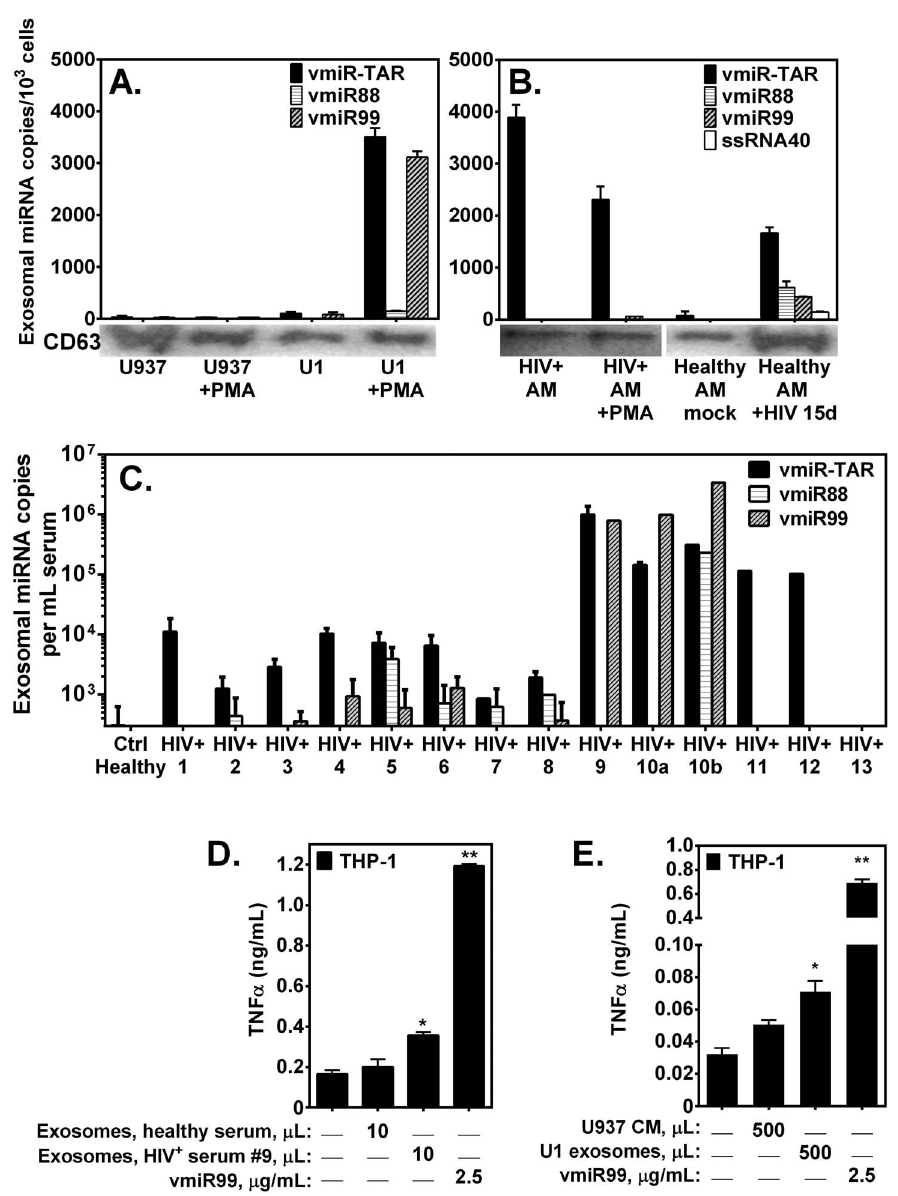
Figure 5. Novel HIV-produced miRNAs are released by HIV-infected human macrophages and associated with exosomes invitro , and detected in sera from asymptomatic HIV + persons. Quantitative PCR measurement of HIV miRNA from exosomal preparation of cultured supernatants from adherent ( A ) human macrophage cell lines U937 and HIV + U1, and ( B ) human alveolar macrophages (established in vitro HIV infection, or from asymptomatic HIV + person), incubated in the absence or presence of PMA for 24 h. Western blot immediately beneath each bar graph demonstrates exosomal marker CD63 associated with corresponding sample. Data reflect a minimum of 4 experiments performed in duplicate. ( C ) Quantitative PCR measurement of HIV miRNA in exosomal preparations from archived sera of asymptomatic HIV + persons with peripheral blood CD4 + T-lymphocyte count , 200 cells/mm 3 . Data reflect measurements performed in duplicate. Results shown include exosome preparations isolated from HIV + sera ( n =14) sampled from HIV + patients (numbered 1–13). Serum samples ‘‘10a’’ and ‘‘10b’’ were drawn on separate days from Patient 10. ( D ) Exosomes were isolated from serum (HIV + serum from Patient 9 or healthy serum) using ExoQuick-TC reagent and resuspended in the original volume of PBS (divalent cation-free). THP-1 macrophages cultured in medium (1.0 mL) were treated with 10 m L of exosome suspension (24 h, 37 u C, 5% CO 2 ). ( E ) THP-1 macrophages were treated (24 h) with 500 m L of conditioned medium (healthy parental U937 macrophages that had been cultured 6 d) or medium-suspended exosomes that had been isolated from 500 m L HIV + conditioned medium (U1 macrophages cultured 6 d). Conditioned medium was analyzed by ELISA for TNF a . *, p , 0.05. doi:10.1371/journal.pone.0106006.g005 studies indicate the importance of nucleotide sequence, although were identified from a highly conserved GU tract in a virus with secondary structure may be more critical to RNA function, with an exceptionally high mutation rate suggests critical, perhaps the poly(A) hairpin [29,36] providing essential stability [30,37]. In essential, functions for these HIV-derived miRNAs. Although addition, the striking observation that both vmiR88 and vmiR99 vmiR-TAR may modulate cellular apoptosis, additional roles of